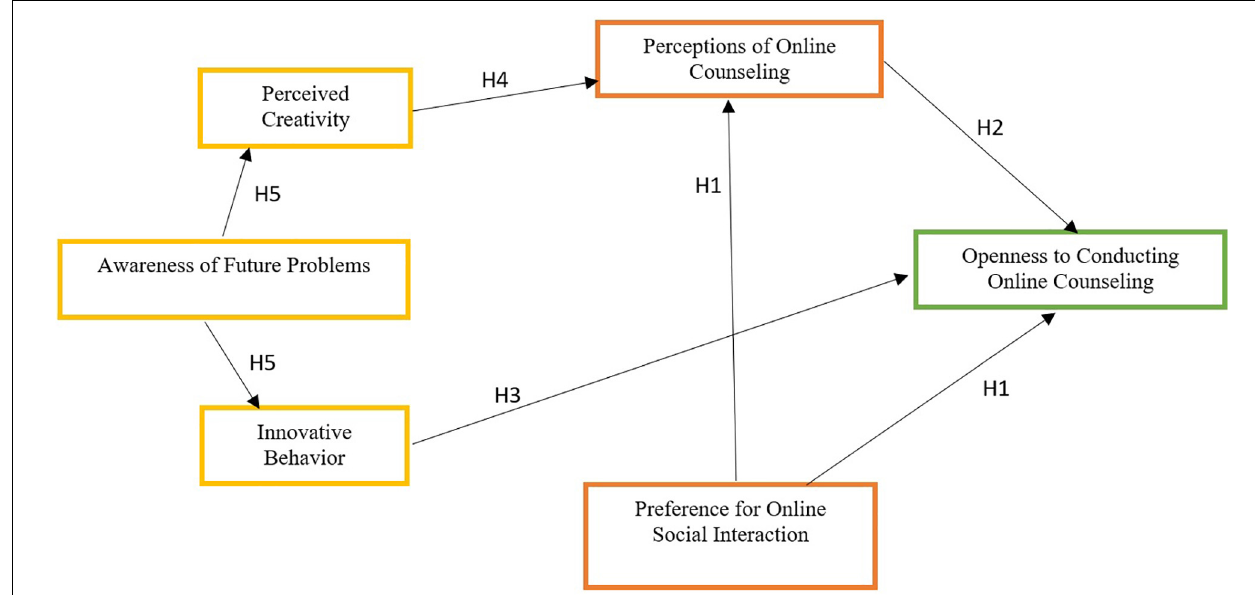
FIGURE 1 | Model 1. The theoretical structure of the proposed